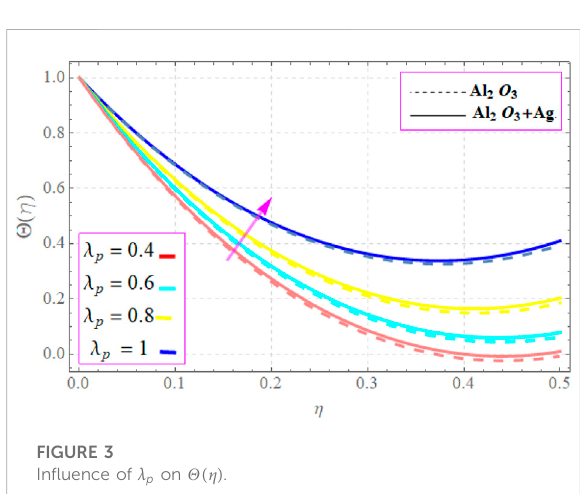
FIGURE 3 In fl uence of λ p on Θ ( η )